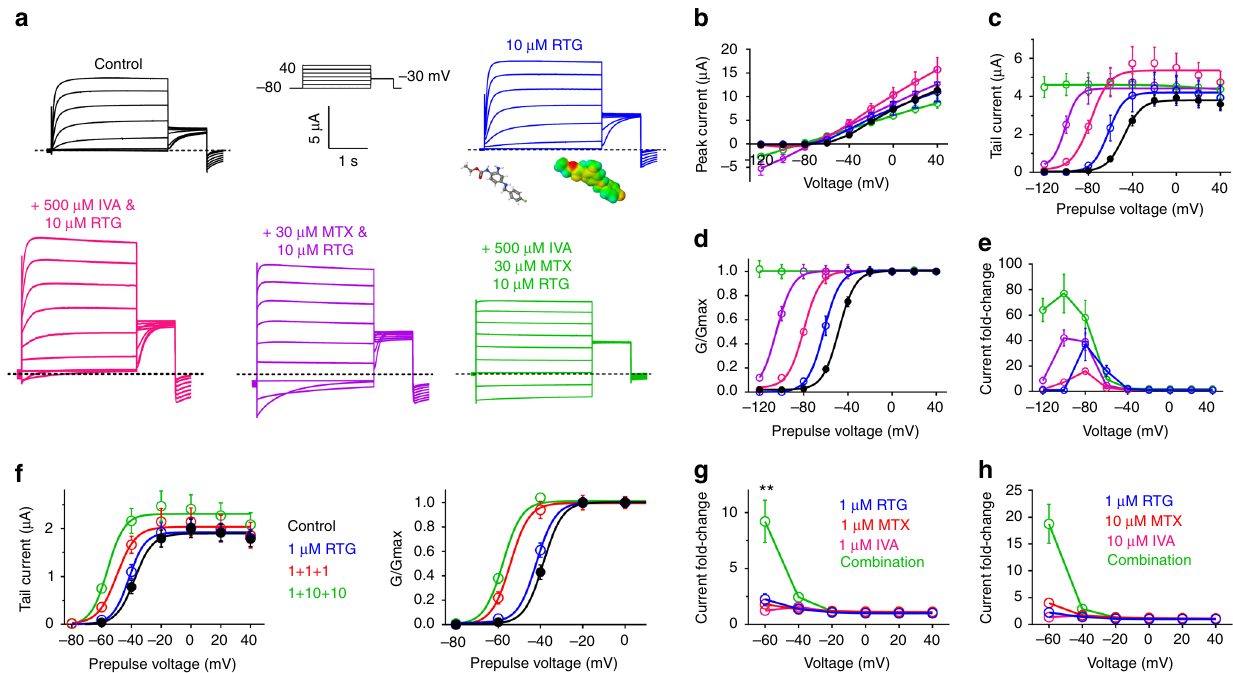
Fig. 7 IVA and MTX synergize with RTG to lock open KCNQ2/3. a Averaged traces showing effects of high-dose RTG, IVA, and MTX alone or in combination on KCNQ2/3 ( n = 5 – 31). Voltage protocol upper inset. b – e Analysis of traces as in a : b peak current; c tail current; d G / G max ; e current fold-